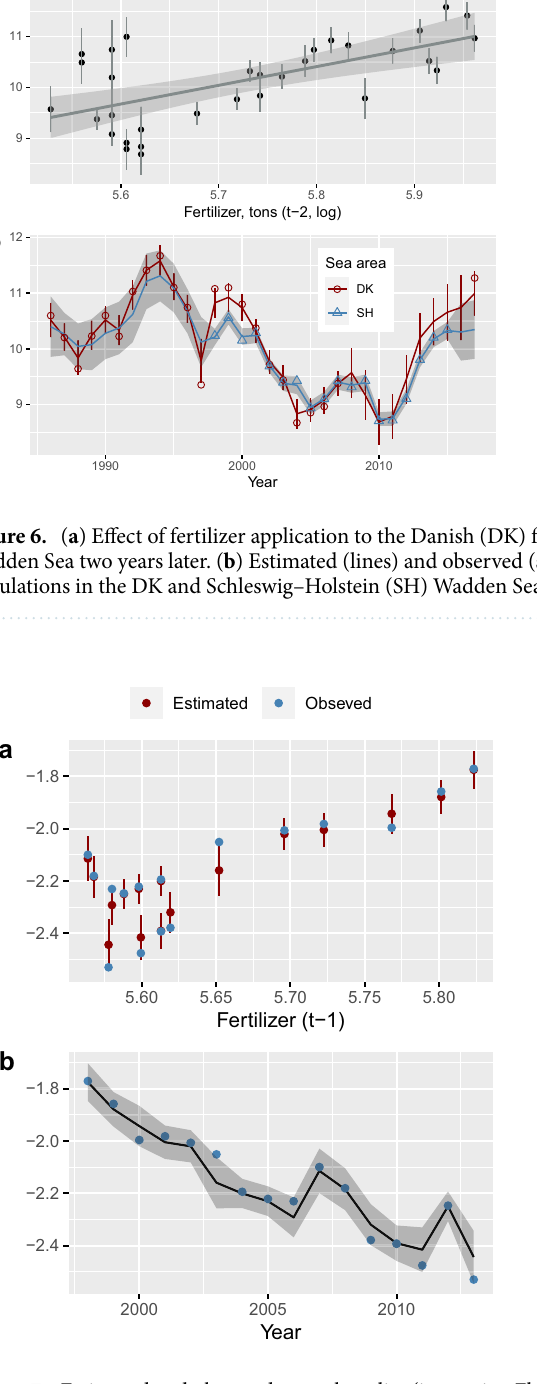
Figure 7. Estimated and observed mussel quality (increasing Flesh/shell ratio means improving quality) based on samples from the Baltic and Wadden Sea and modelling with Eq. (6). ( a ) Flesh/Shell ratio plotted against fertilizer use in the Danish farmland in the previous year. ( b ) Trajectory of Flesh/shell ratio during the period